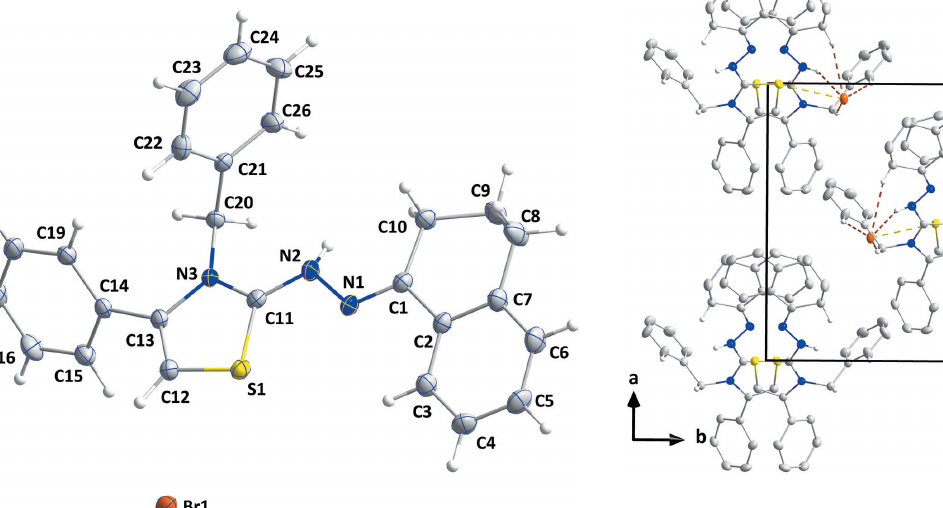
Figure 3 Packing seen along the c -axis direction giving an end view of the